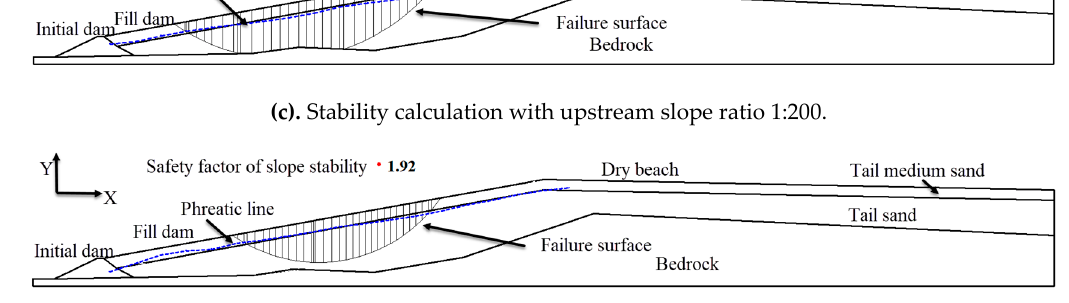
(d). Stability calculation with upstream slope ratio 1:300. Figure 11. Stability calculation with dry beach lengths and Stability calculation with upstream slope ratio. ( a ) 100 m; ( b ) 200 m (upstream slope ratio 1:100); ( c ) 1:200; ( d ) 1:300.